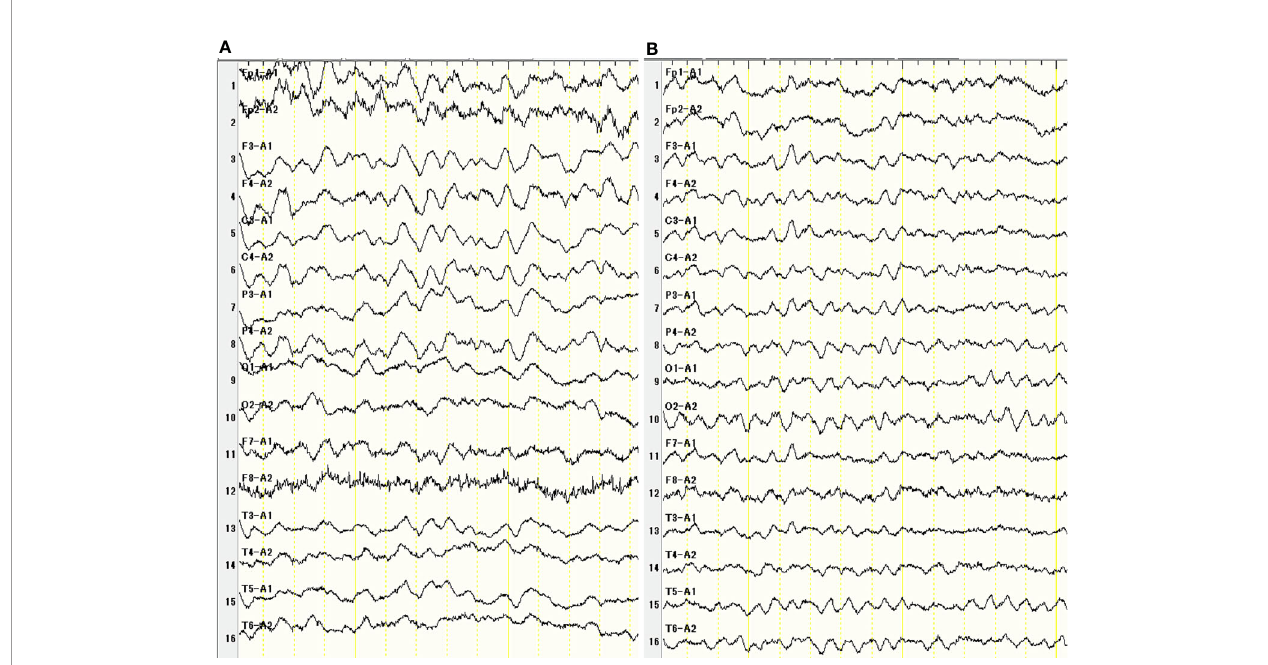
FIGURE 2 | Thirty-one days after chemotherapy, Electroencephalogram showed diffuse slow wave (45 Hz) (A) . There were no seizures. EEG improved after steroid pulse therapy (B)